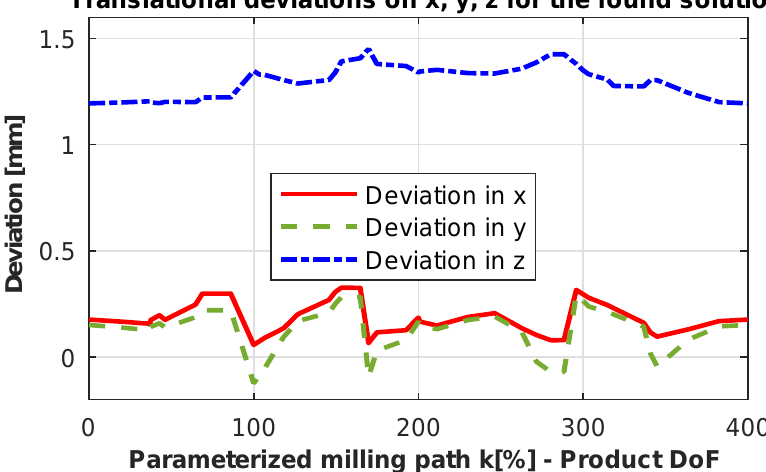
Figure 14. Translation deviations on x , y , z for the found solution.